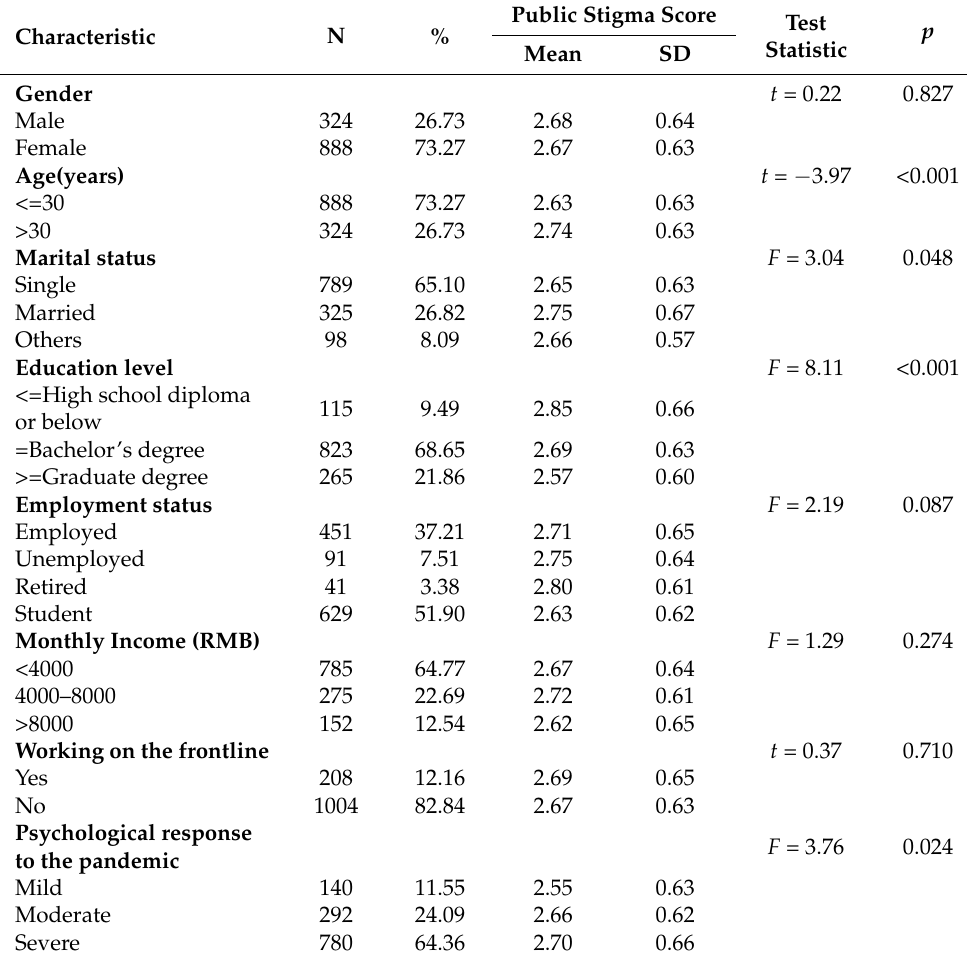
Table 1. Sociodemographic characteristics and their differences in public stigma